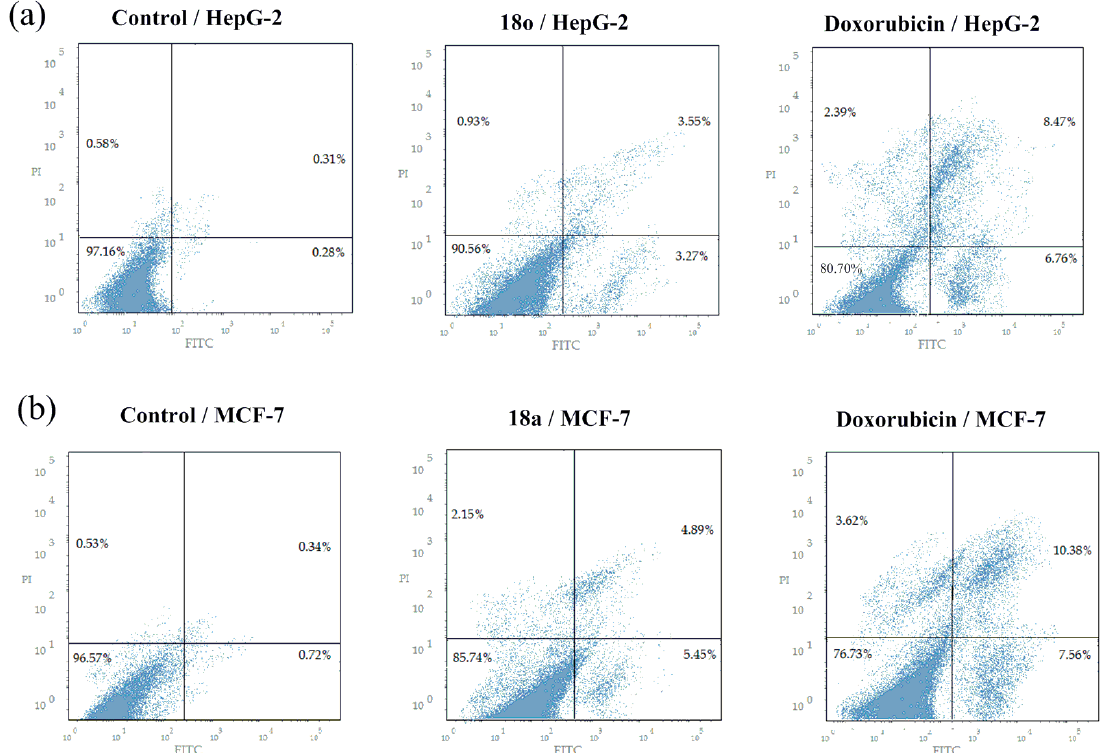
Figure 6. ( a ) Effect of compound 18o on the percentage of annexin V-FITC positive staining in HepG-2 cancer cells, the cells were treated with DMSO as control and with doxorubicin as a positive control, for 24 h. ( b ) Effect of compound 18a on the percentage of annexin V-FITC positive staining in MCF-7 cancer cells, the cells were treated with DMSO as control and with doxorubicin as a positive control, for 24 h.